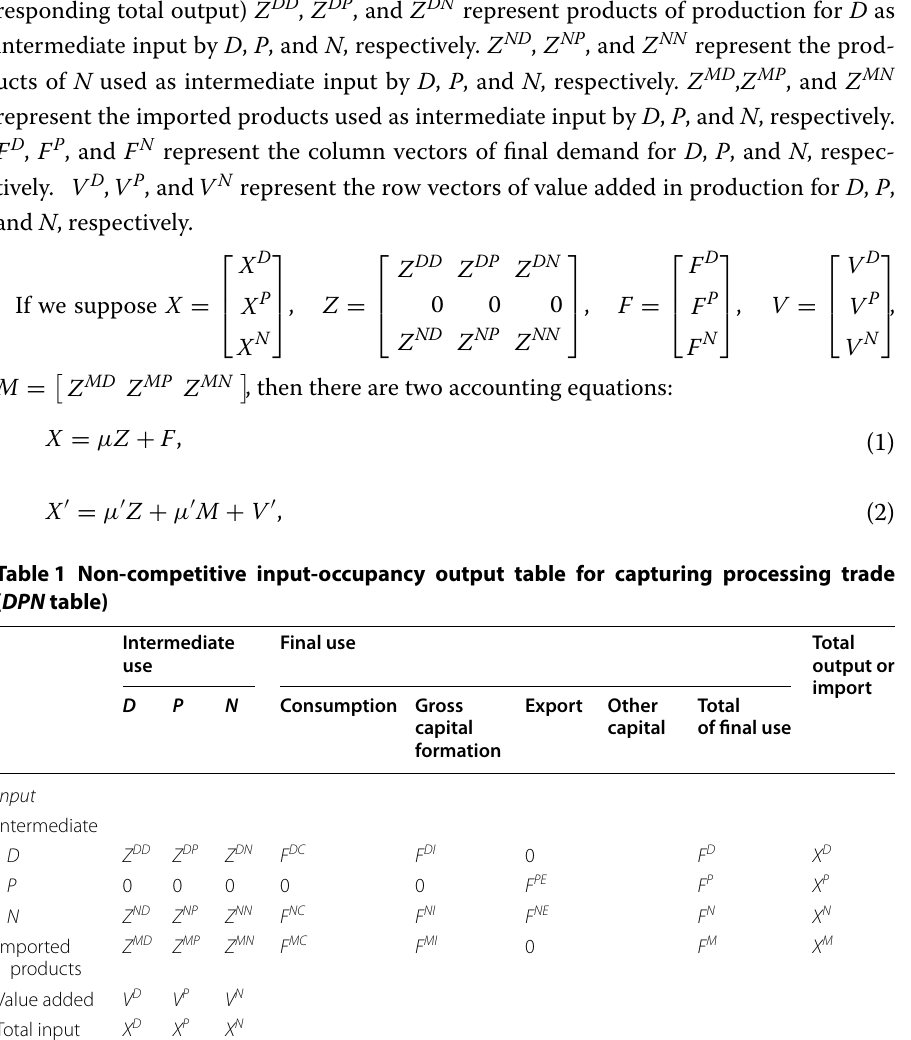
The superscripts D, P, and N denote production for domestic use, production for processing trade exports, and production for normal trade exports,